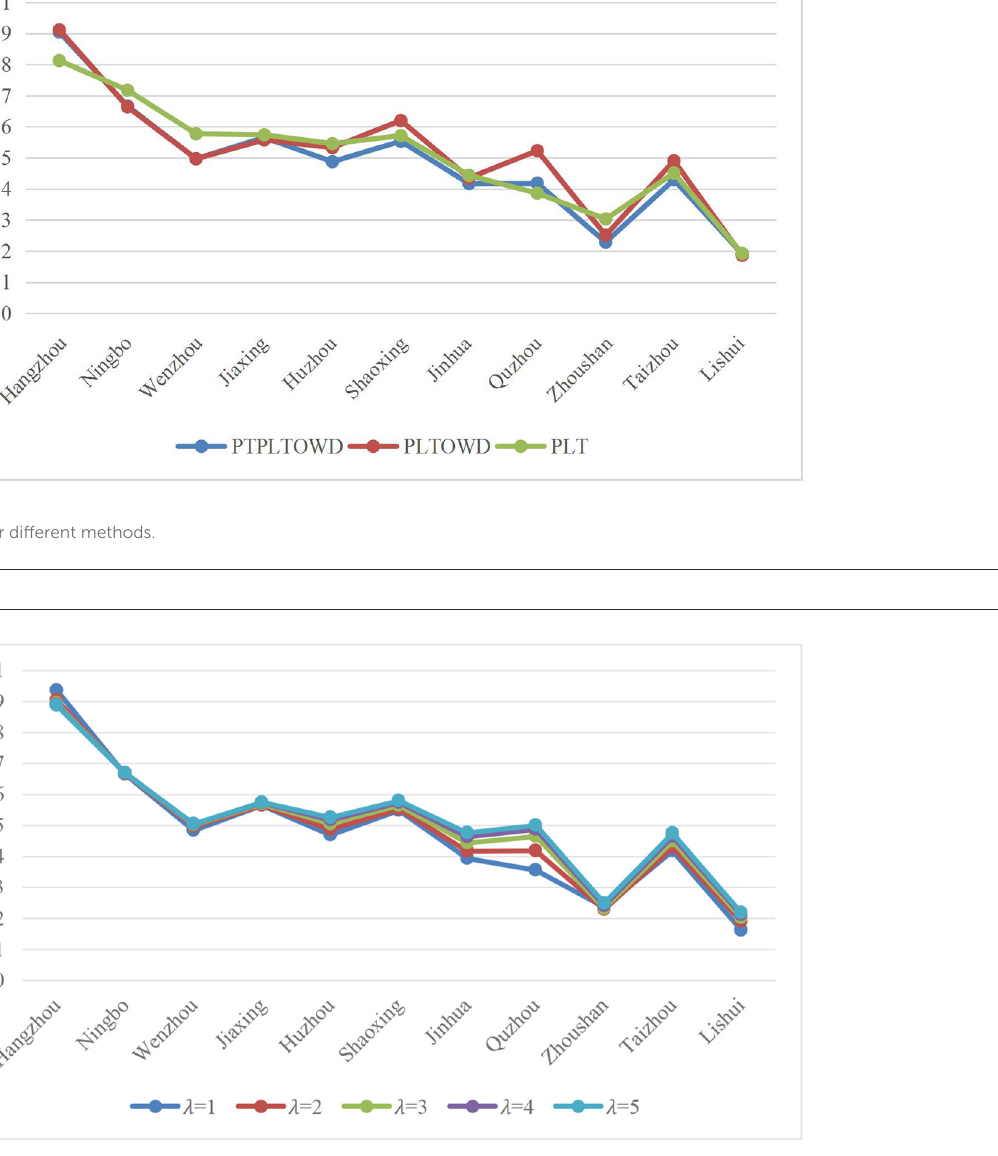
FIGURE4 Influence of λ on the degree of